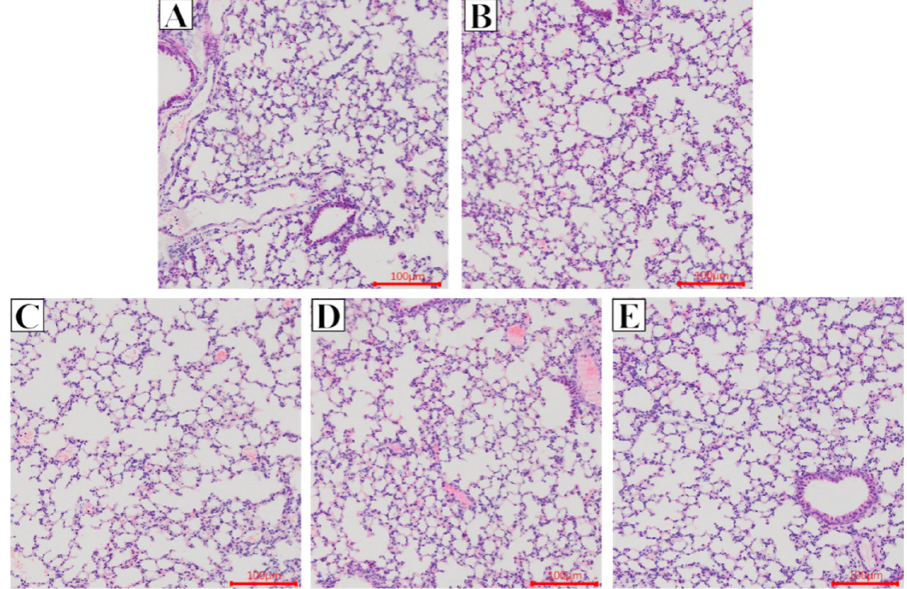
Figure 1. Effect of Glycine nano-selenium on pathological changes of lung tissue ( A – E , 200×). The lung texture of mice in each group was clear, the alveolar structure was complete, and there were no obvious pathological changes (n = 5). Control, received no immunization + 0.5 mL normal saline; positive received H9N2 AIV vaccine + 0.5 mL 0.9% normal saline; 0.25 mg/kg group, received H9N2 AIV vaccine + 0.5 mL 0.25 mg/kg selenium solution; 0.5 mg/kg group, received H9N2 AIV vaccine + 0.5 mL 0.5 mg/kg selenium solution; 1 mg/kg group, received H9N2 AIV vaccine + 0.5 mL 1 mg/kg selenium solution.